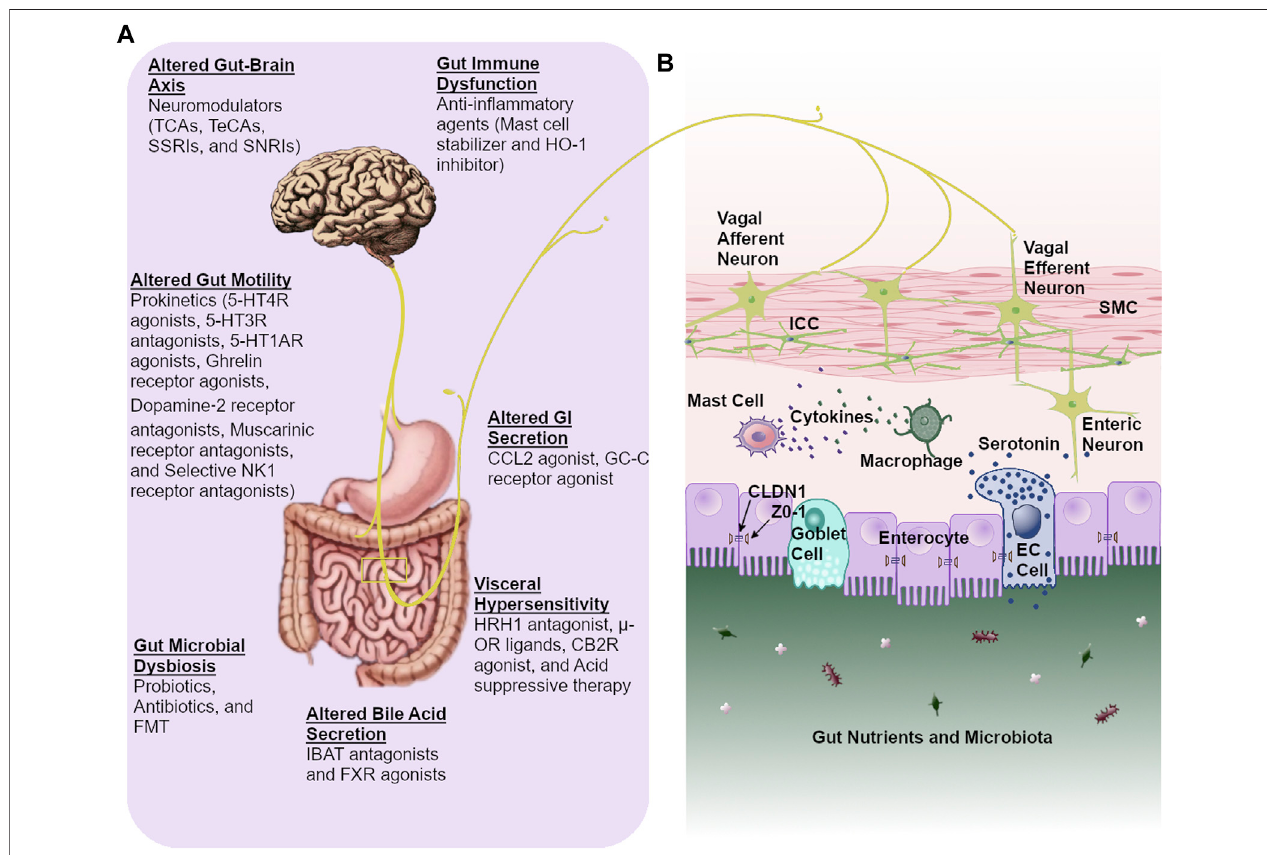
FIGURE 1 | Pathophysiology-directed therapeutic approach for gastrointestinal dysmotility and functional gastrointestinal disorders. (A) . Currently available pharmacological agents based on pathophysiological mechanisms (B) . Proper gut functioning relies on acoordinated communication between intestinal epithelial cells, enteric neurons, gastrointestinal pacemaking cells, and immune cells. This allows for essential crosstalk between the gut microbiota, gut, and brain. Abbreviations: CCL2: chloride channel 2, CB2R: cannabinoid type 2 receptor, CLDN1: claudin 1, TCAs: tricyclic anti-depressants, TeCAs: tetracyclic anti-depressants, SSRIs: selective serotonin reuptake inhibitors, IBAT: ileal bile acid transporter, HO-1: heme oxygenase-1, 5-HT1AR: serotonin 1A receptor, NK1: neurokinin 1, FMT: fecal microbiota transplantation, FXR: farnesoid X receptor, HRH1: histamine receptor-1, µ-OR: μ -opioid receptor, GC-C: guanylate cyclase-C, ICC: interstitial cells of Cajal, EC: enterochromaf fi n, ZO-1: zonula occludens-1, SNRIs: serotonin noradrenaline reuptake inhibitors, SMC: smooth muscle cell.